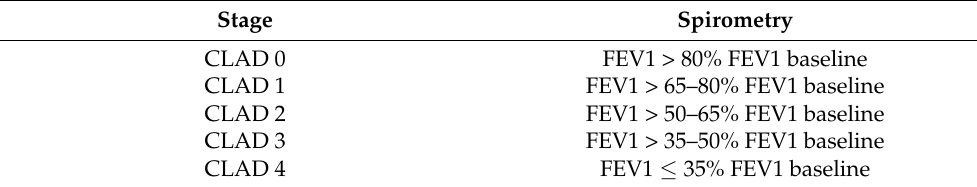
Table 2. CLAD staging (from [5]).